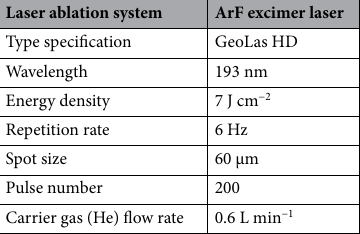
Table 1. Laser ablation system operating condition.